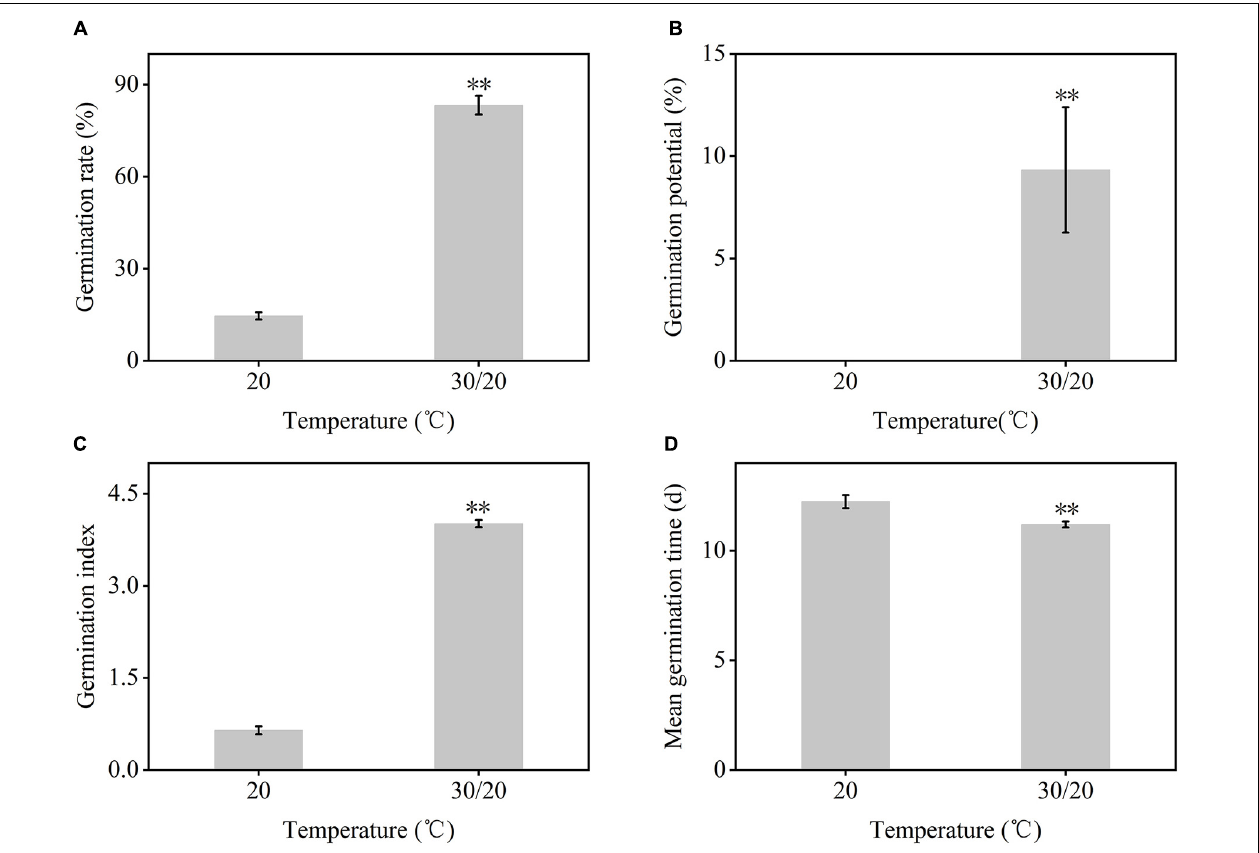
FIGURE 2 | Germination indexes of Carex rigescens seeds under different temperature conditions. (A) Germination rate. Germination rate (%) = Number of final seed germination/number of tested seeds × 100%. (B) Germination potential. Germination potential (%) = Number of seeds germinated in the first 3 days of the germination/number of tested seeds × 100%. (C) Germination index. Germination index = (cid:54) (Gt/Dt), where Gt is the number of germinated seeds in a day, and Dt is the corresponding germination days. (D) Mean germination time. Mean germination time (d) = (cid:54) nt/ (cid:54) n, where n is the number of newly germinated seeds on day t, and t is the number of germination days. Data are expressed as mean ± SD ( n = 3). ∗∗ Indicates that the germination indexes between variable temperature and constant temperature were significantly different at P < 0.01 based on independent-samples T